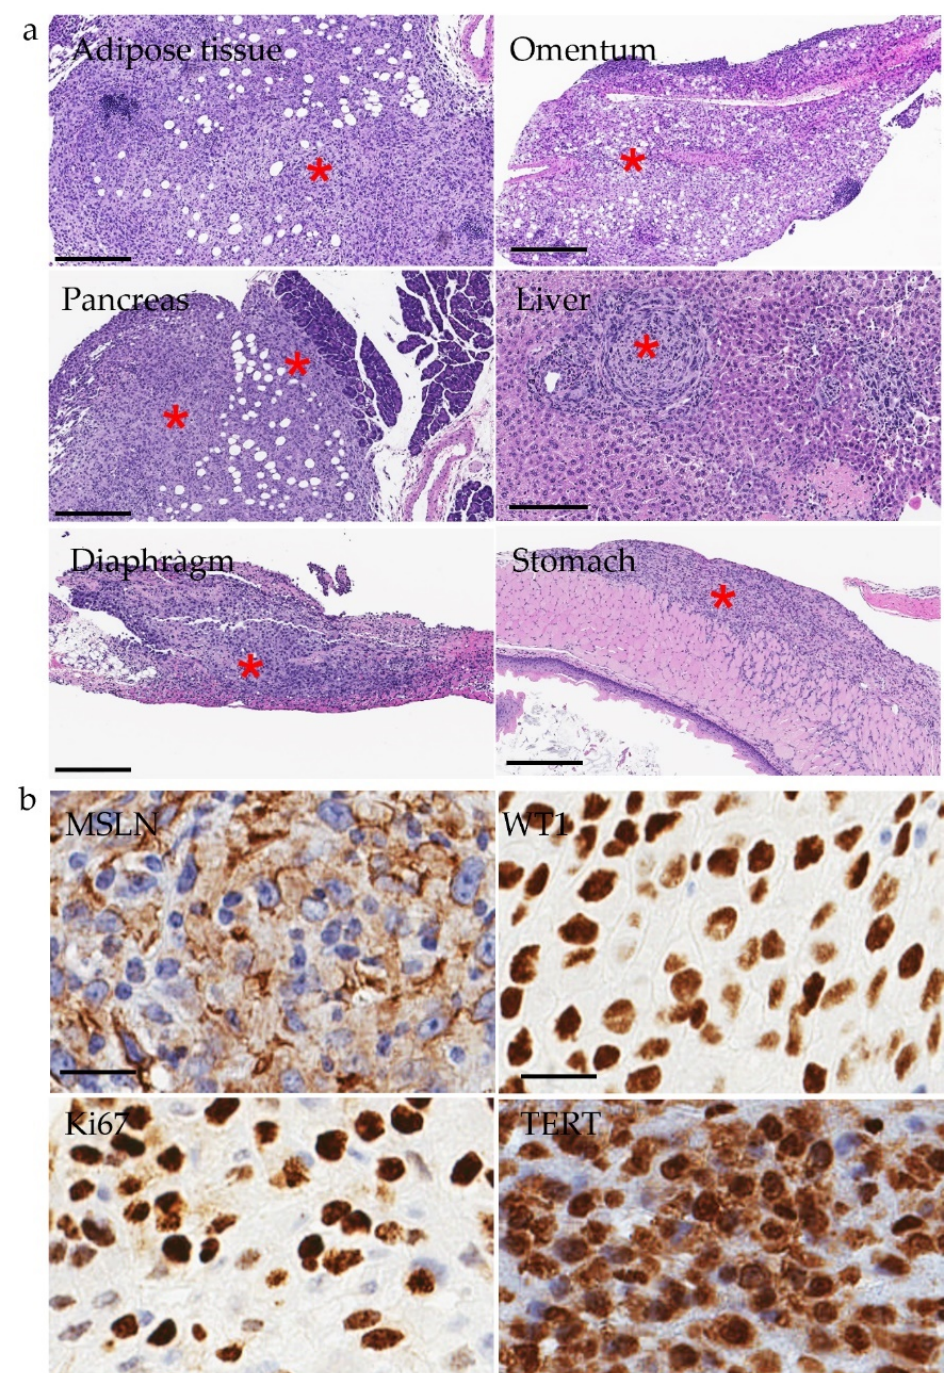
Figure 2. ( a ) H.E. staining of MM201 cells growing in mesenteric adipose tissue and along the serosal surfaces (e.g., omentum, pancreas, liver, diaphragm, and stomach). * Tumor cells. Scale bar: 200 um. ( b ) IHC staining of MSLN, WT1, Ki67, and TERT in MM201 i.p. tumors. Scale bar: 50 um. Whole-exome sequencing (WES) studies have shown that human pleural MMe have a very low average number of somatic mutations. In one investigation, the number of mutations per tumor ranged from 2 to 52, corresponding to an average of 0.79 mutations per megabase (range: 0.07–1.71) [34]. A larger WES study, performed by The Cancer